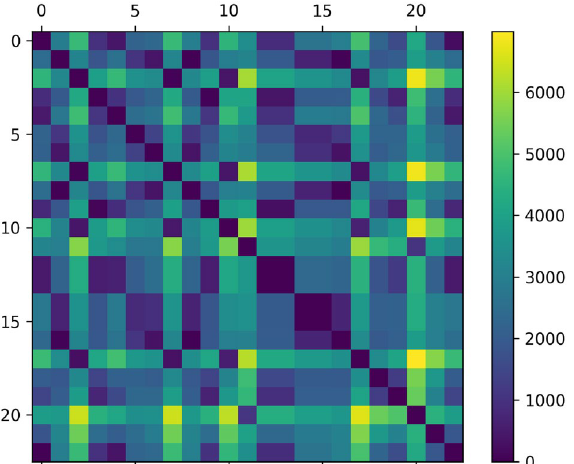
Figure 2. The matrix of driving times between the 23 nodes in the Aisin logistical routing problem. Units are in seconds which is the same unit used for the PUBO construction (figure generated by the authors using matplotlib 3.6.3 found at https:// pypi. org/ proje ct/ matpl